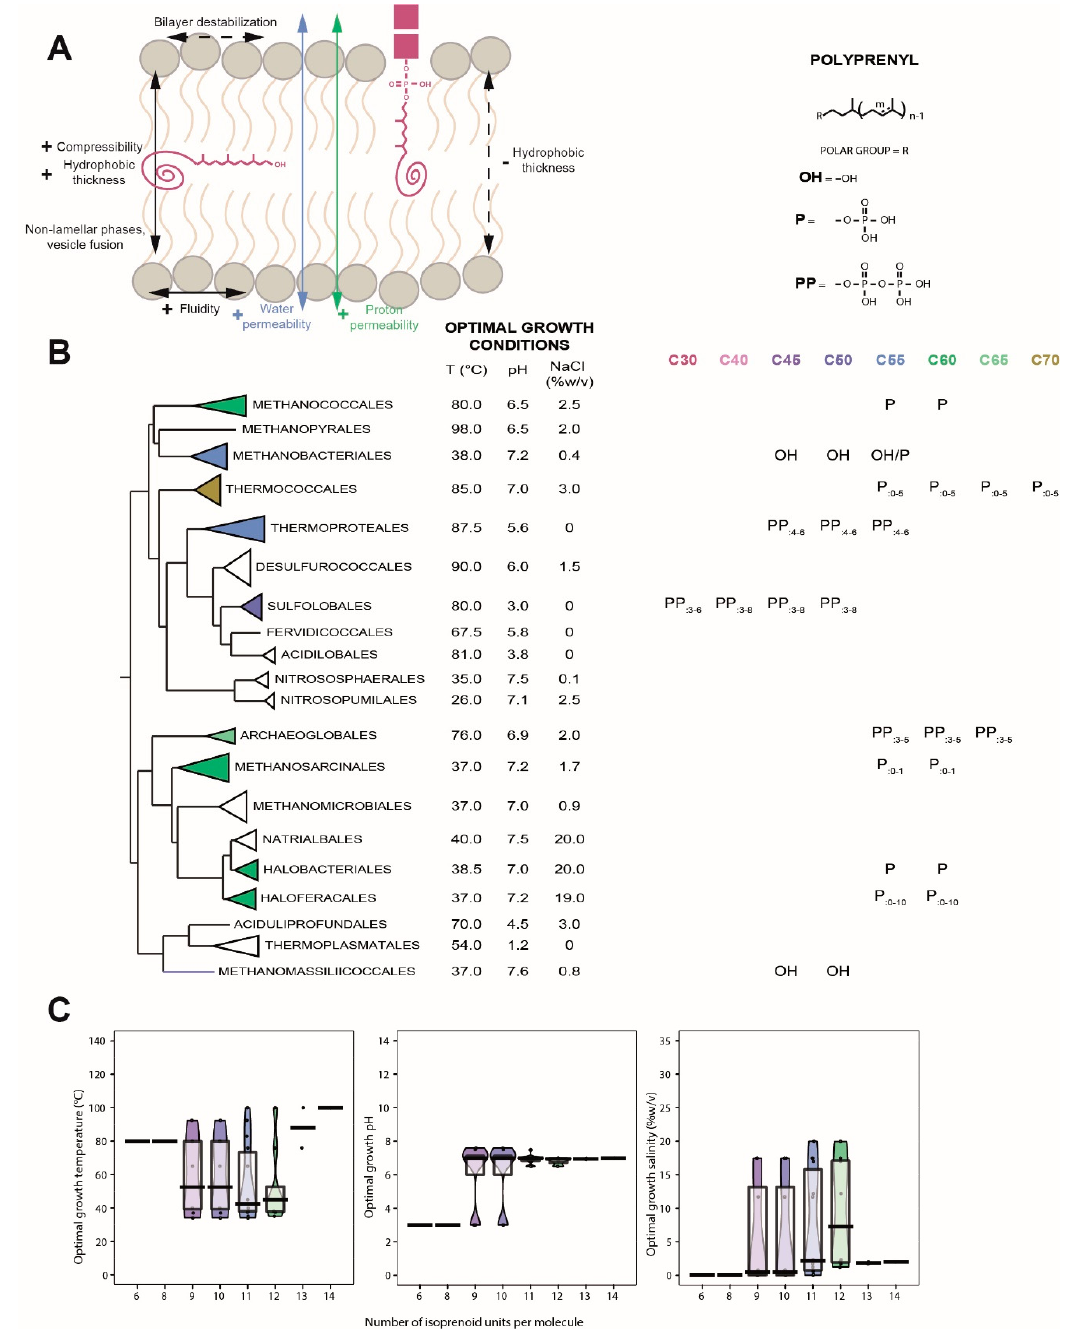
Figure 3. Physicochemistry, distribution and adaptive response of polyprenols in Archaea. ( A ), Position and impacts of polyprenols on membrane physicochemical properties. ( B ), Structures and